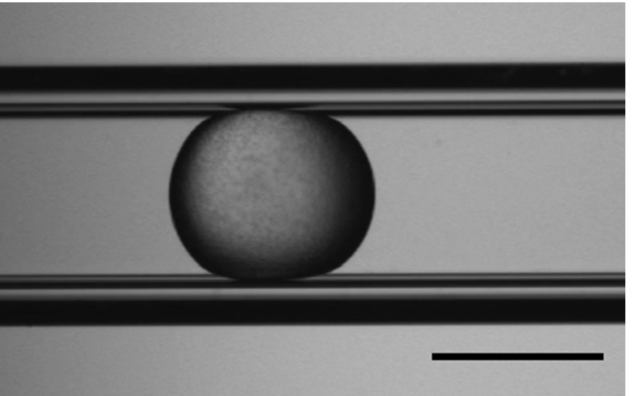
Figure 4. An individual double emulsion droplet flowing through the squared capillary. The scale bar is equal to 1